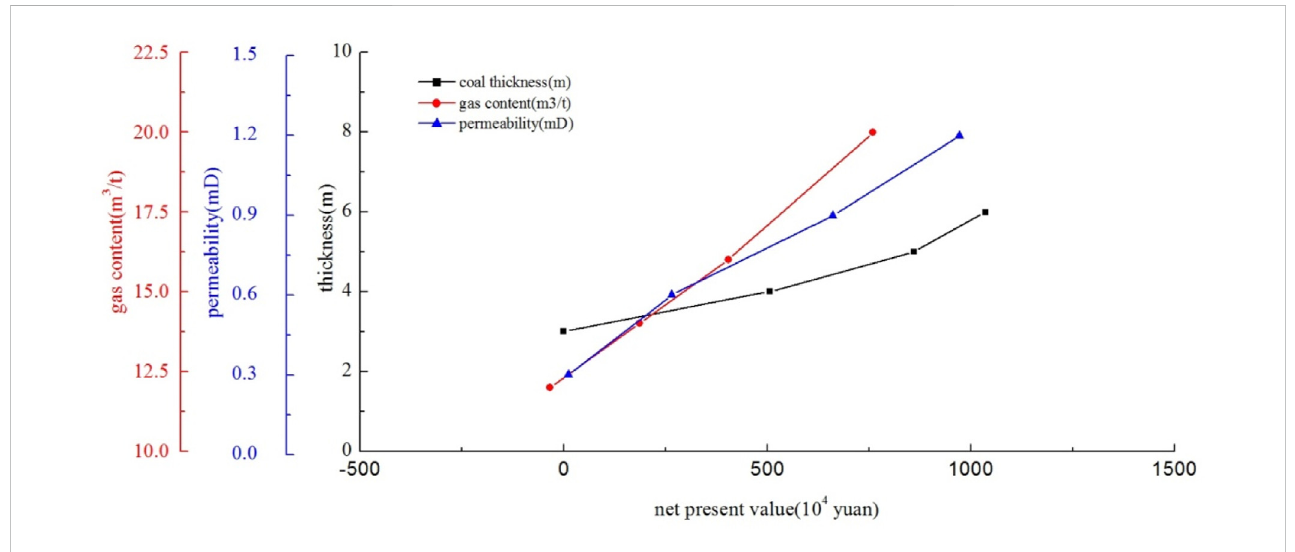
FIGURE 7 Variation curve of gas production with coal